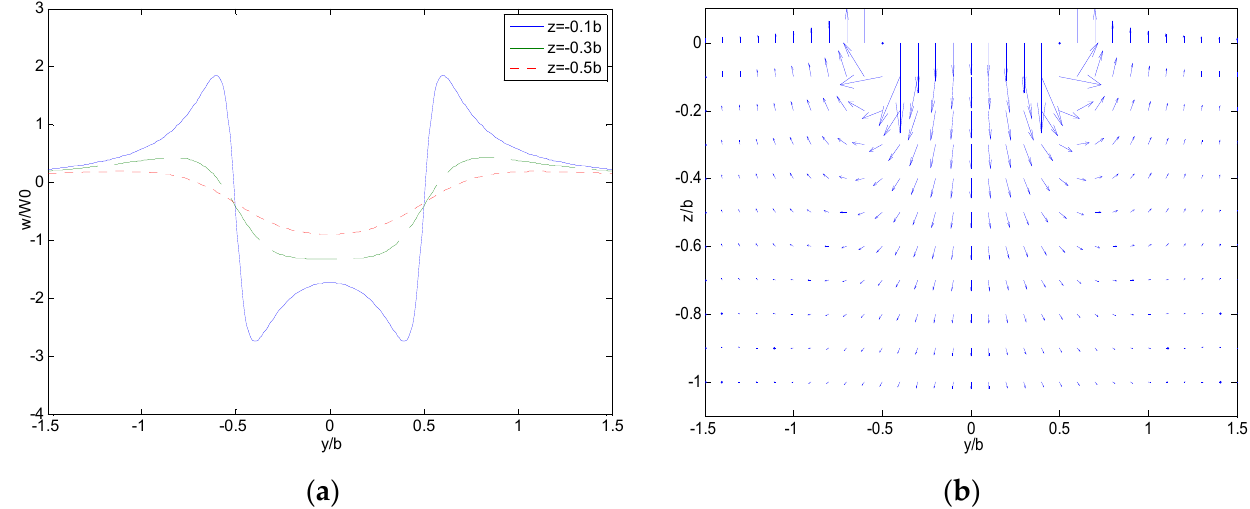
Figure 5. Induced vertical velocity distribution by wingtip vortices model on yz plane at x = 2 b downstream: ( a ) z = − 0.1 b , − 0.3 b , − 0.5 b below wingtip vortices; ( b ) two-dimensional velocity field on yz plane ( x = 2 b ).